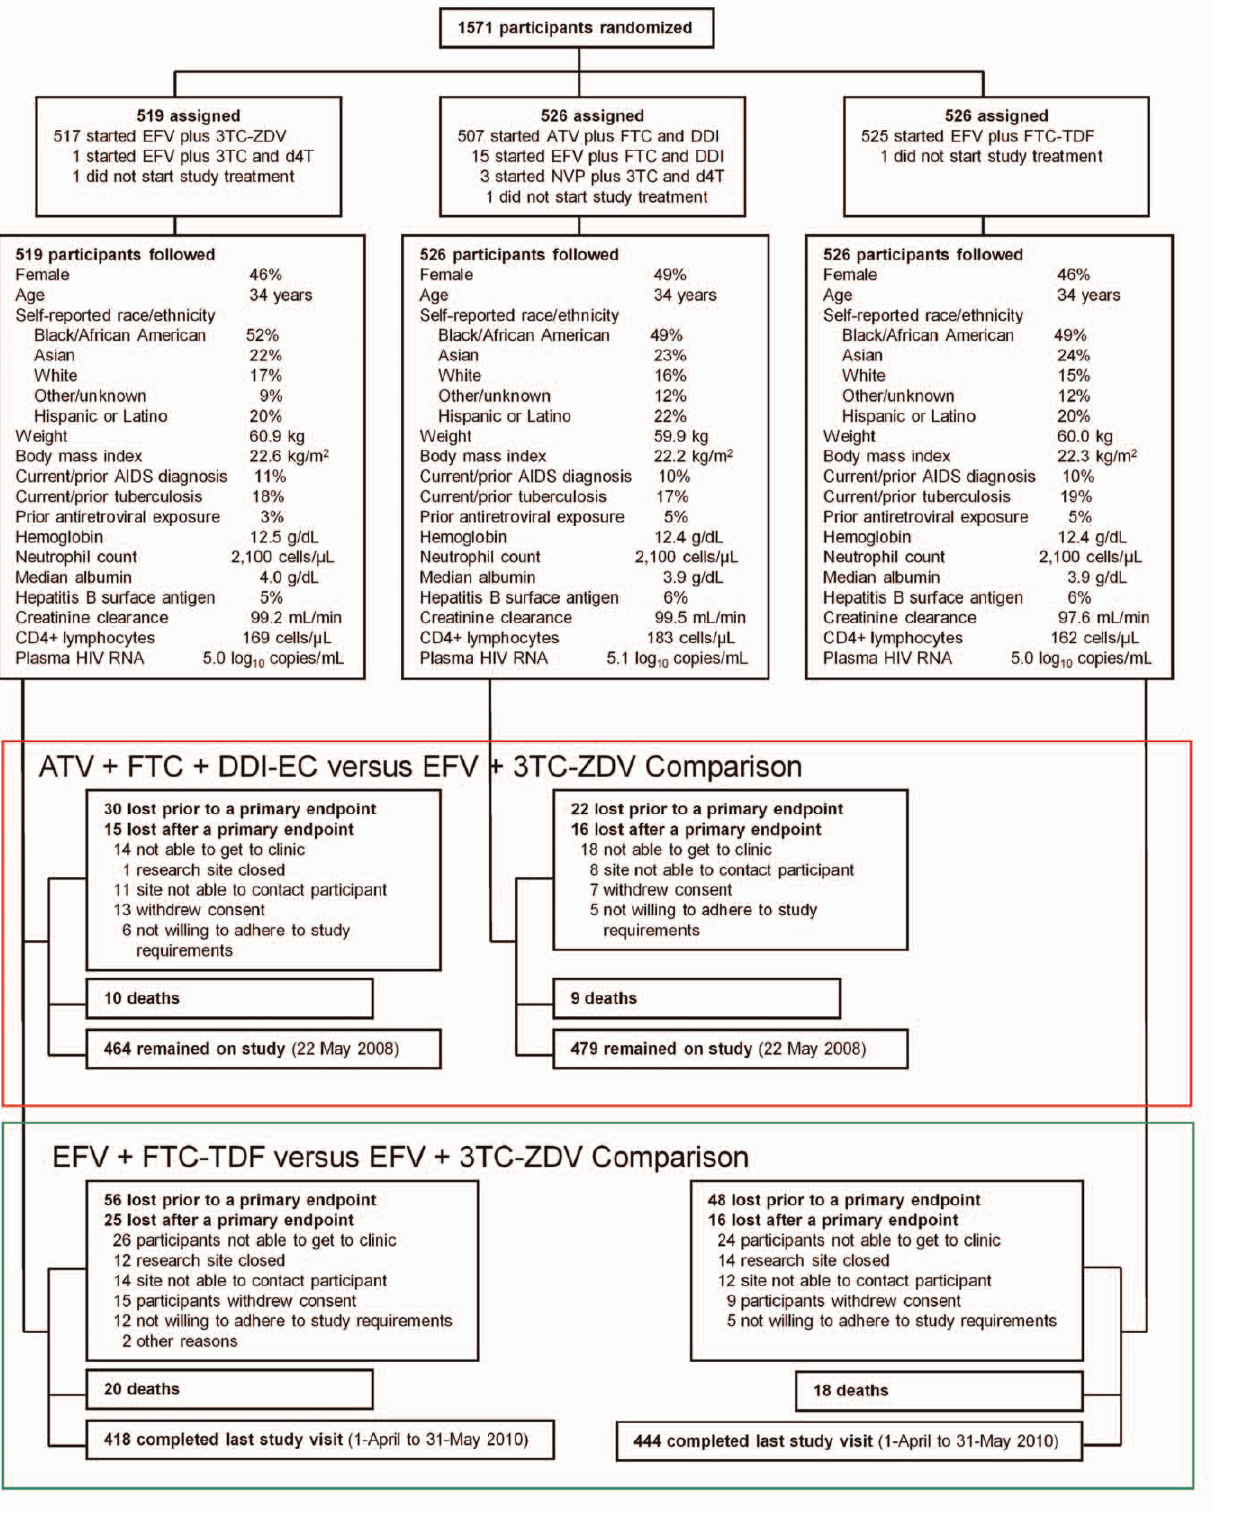
PLOS Medicine | www.plosmedicine.org 6 August 2012 | Volume 9 | Issue 8 |